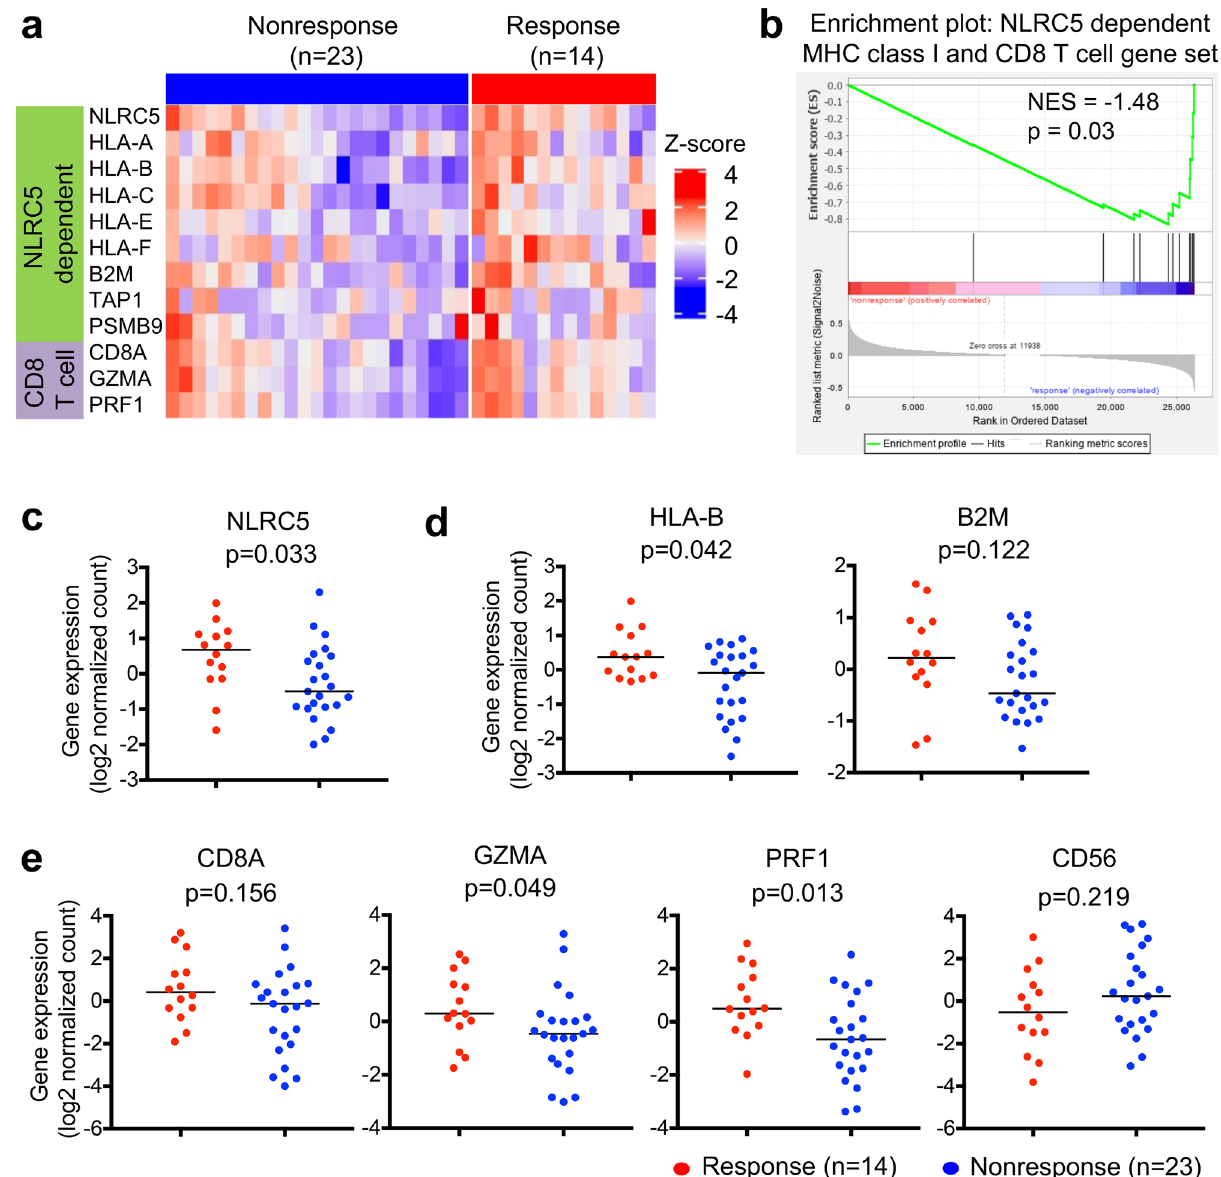
Figure 1. The expression of NLRC5-dependent MHC class I and CD8+ T cell genes are correlated with response to anti-CTLA-4 antibody therapy. Patients groups who benefitted from anti-CTLA4 antibody therapy (Response, n = 14) and who did not (Nonresponse, n = 23) were analyzed for differential gene set enrichment by ( a ) heatmap and ( b ) GSEA as well as individual gene expression levels of ( c ) NLRC5 , ( d ) HLA-B , B2M , ( e ) CD8A , granzyme A ( GZMA ), perforin ( PRF1 ) and CD56 . Bar represents the median value. P-values calculated using Mann–Whitney U test. NES, normalized enrichment